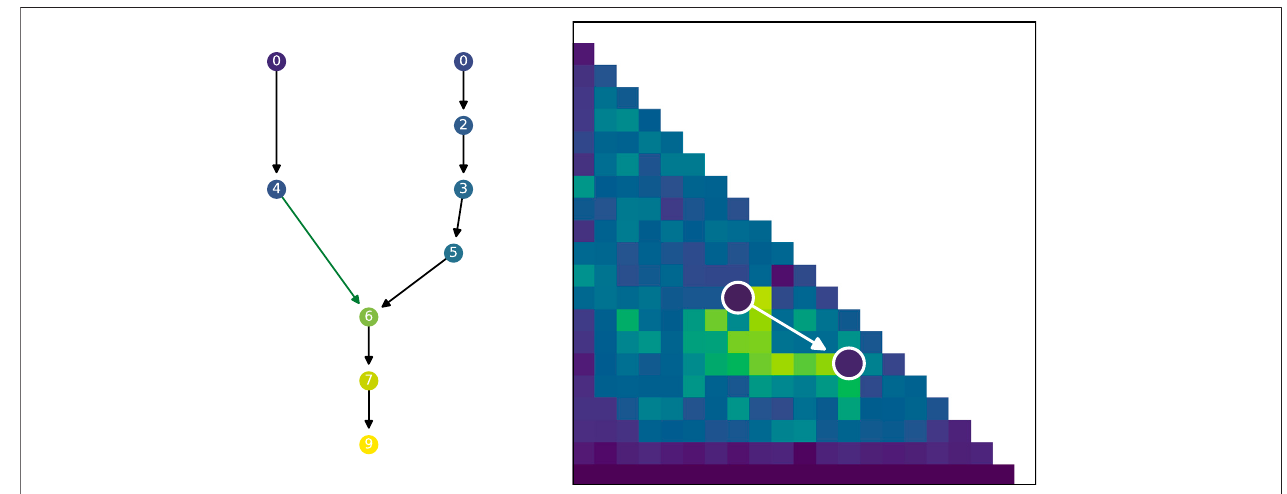
FIGURE 10 | Visualized ancestry of a solution. On the left the circles represent solutions that are ancestors of the bottom most circle. The color of the circle represents the fi tness of the solution. The number is the generation when the solution appeared in the population. Arrows indicate parenthood, where black arrows indicate that there is no morphological difference and green arrows indicate a morphological difference between parent and child. The two arrows joining to one new solution corresponds to a crossover operation while the other arrows correspond to mutation operations. On the right the tree is projected back into a repertoire and shows that the whole tree developed in just two different morphological descriptions, the white arrow indicates a change from parent to child in morphology.